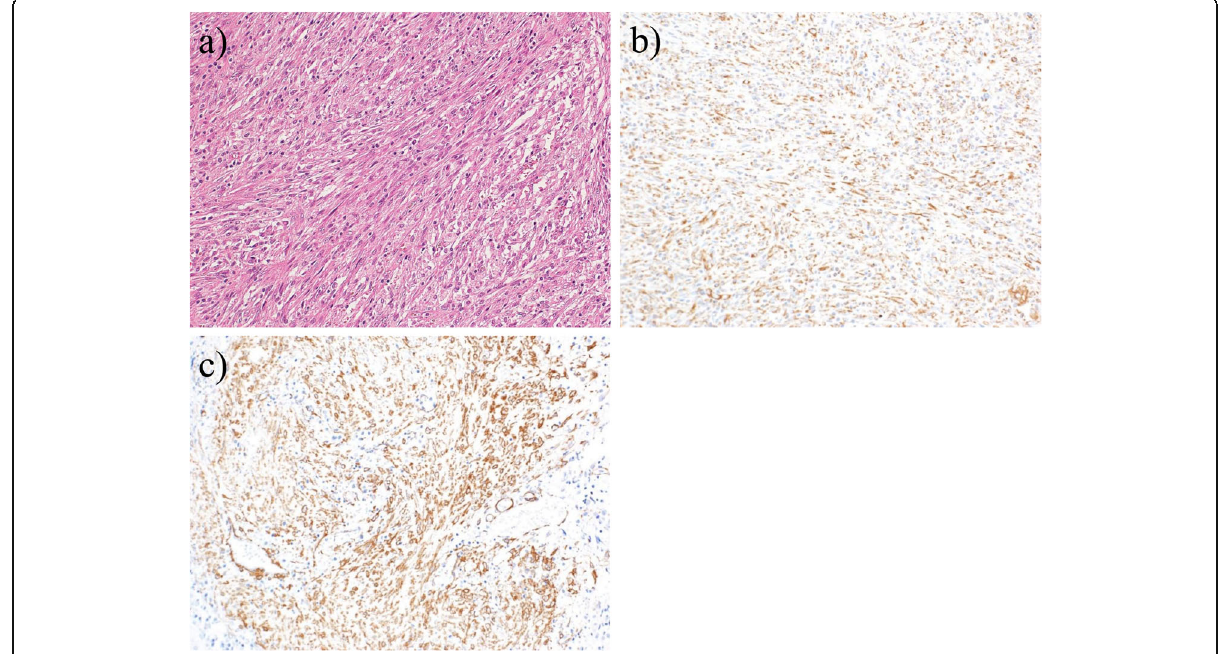
Fig. 3 Histopathological findings. a Histopathological examination using hematoxylin and eosin staining revealed spindle cell proliferation and significant inflammatory cell infiltration, magnification × 200. b , c Immunohistochemistry showed that the spindle-shaped cells were strongly positive for vimentin ( b ) and smooth muscle actin (SMA) ( c ), magnification ×